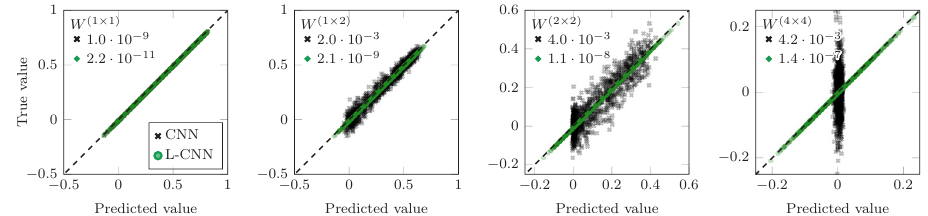
Figure 2. Scatter plots of our best L-CNN and baseline CNN models according to validation MSE on 8 8 lattices. True values of the Wilson loop are plotted against the predictions of the L-CNN model · (green dots) and the baseline CNN (black crosses). High accuracy is achieved when all points are distributed close to the 45 ◦ line. The MSE is stated in the upper left corner of each panel. We observe that our best L-CNN models achieve low MSE for all studied loop sizes, while baseline CNNs perform worse at larger loop sizes. Figure adapted from